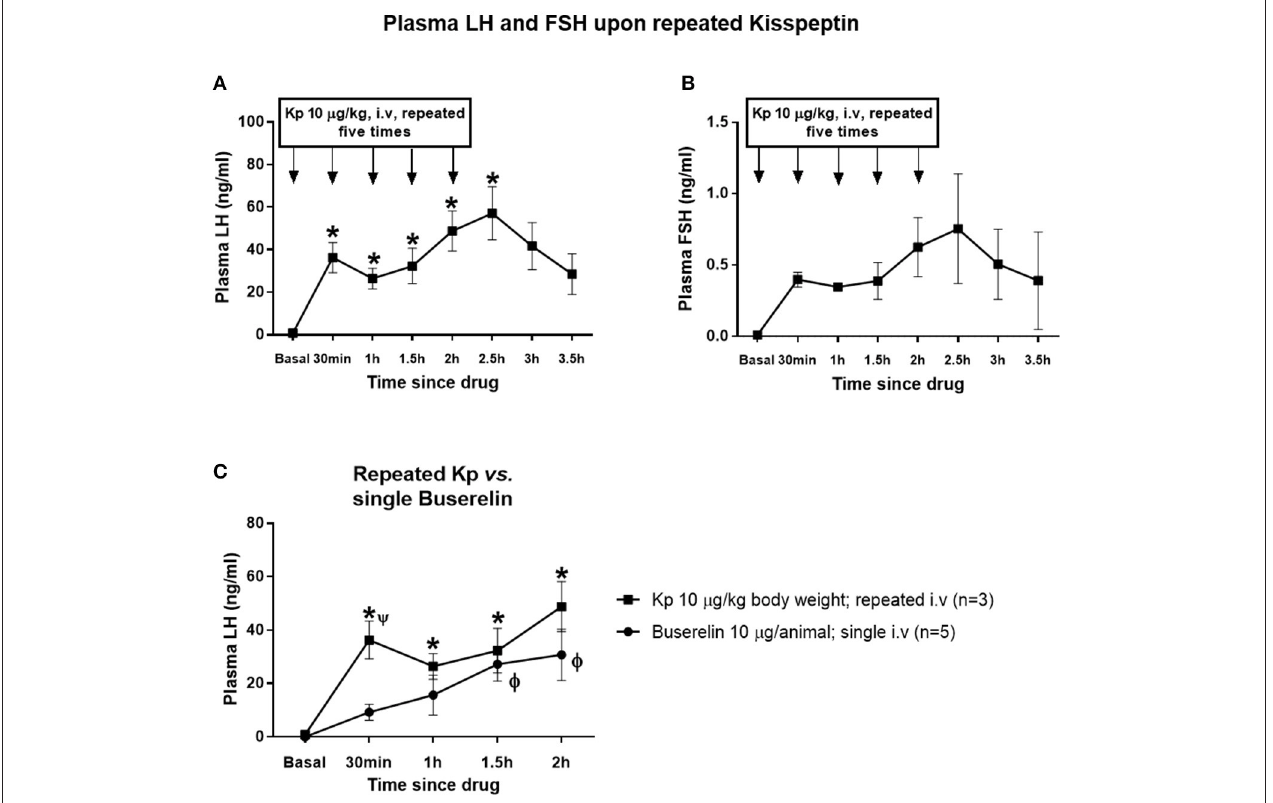
FIGURE 4 | Effect of repeated administration of kisspeptin on plasma LH and FSH. (A) Repeated administration of kisspeptin (10 µ g/kg) elevated LH in a sustained manner (*vs. basal; P < 0.05, one-way RM ANOVA). (B) There was no significant increase in FSH level upon repeated administration of kisspeptin. (C) LH levels upon repeated kisspeptin administration were higher than that upon a single injection of buserelin (*kisspeptin: basal vs. all time points; φ buserelin: basal vs. 1.5 and 2h; 9 buserelin vs. kisspeptin at 30min; RM ANOVA followed by Dunnett’s and Sidak’s multiple comparison test). Data represented as mean ± SEM ( n = 3–5 animals at each time